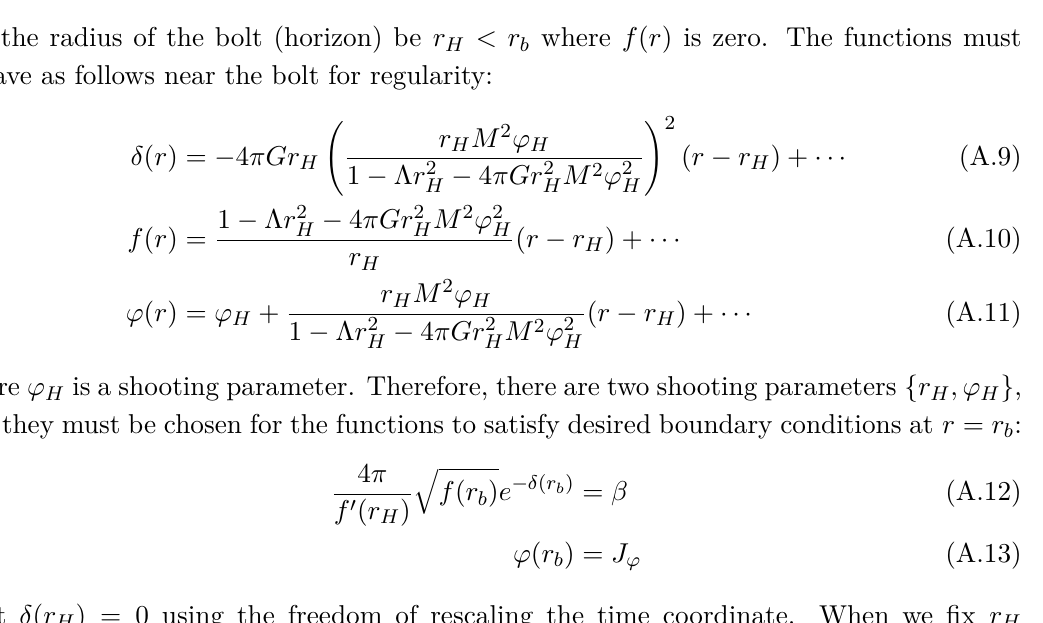
√ √ √ √ G, 2 G, 3 G, 4 G , and 4 . 5